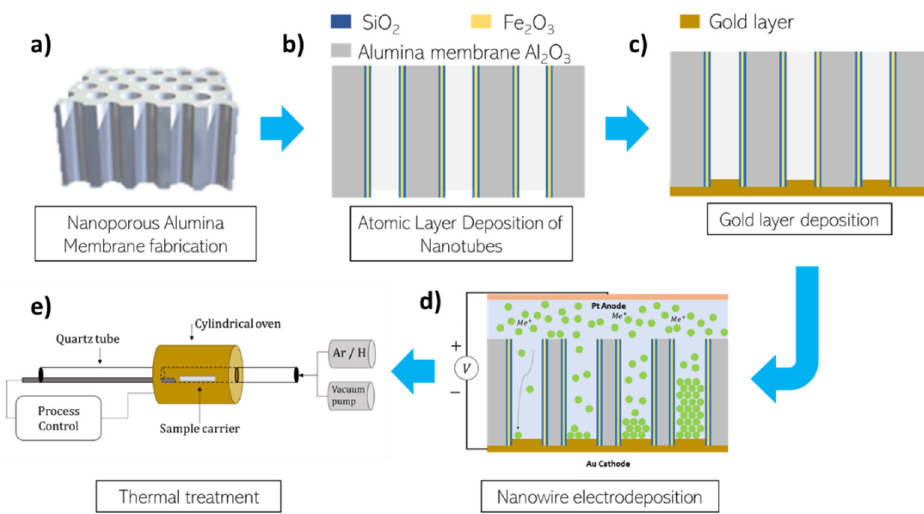
Figure 1. Scheme of the additive fabrication process process to obtain SiO 2 /Fe 2 O 3 /SiO 2 /FeCo core/shell nanotubes/nanowires, and further thermal treatment for Fe 2 O 3 (hematite) reduction into Fe 3 O 4 (magnetite). ( a ) Nanoporous alumina template, ( b ) deposition of nanotubes shell by ALD, ( c ) gold contact layer deposition by sputtering, ( d ) electrochemical deposition of metallic nanowire core, ( e ) thermal annealing under reducing atmosphere.